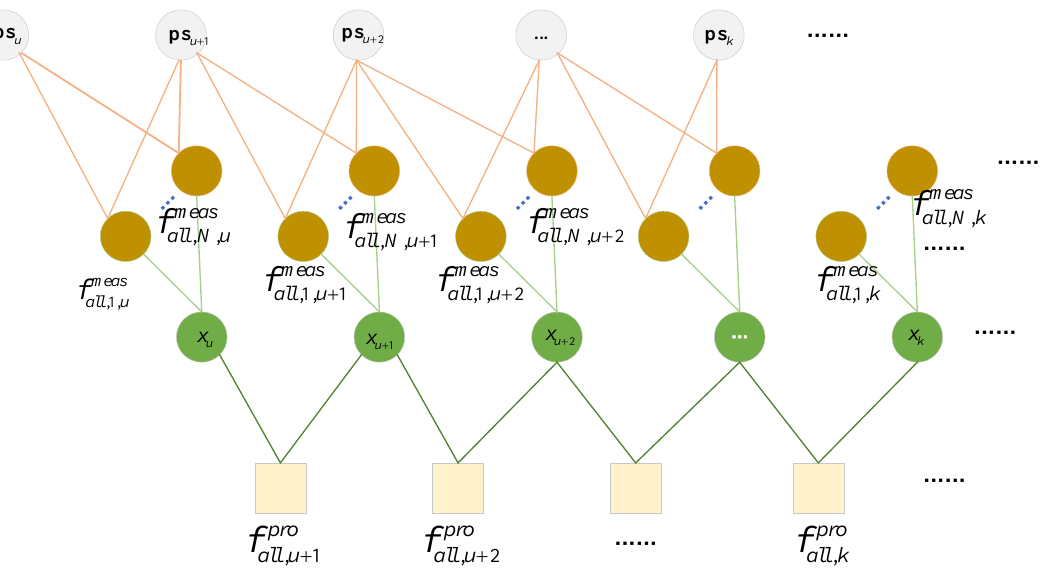
Figure 3. The factorial optimization model architecture for BDAPS.